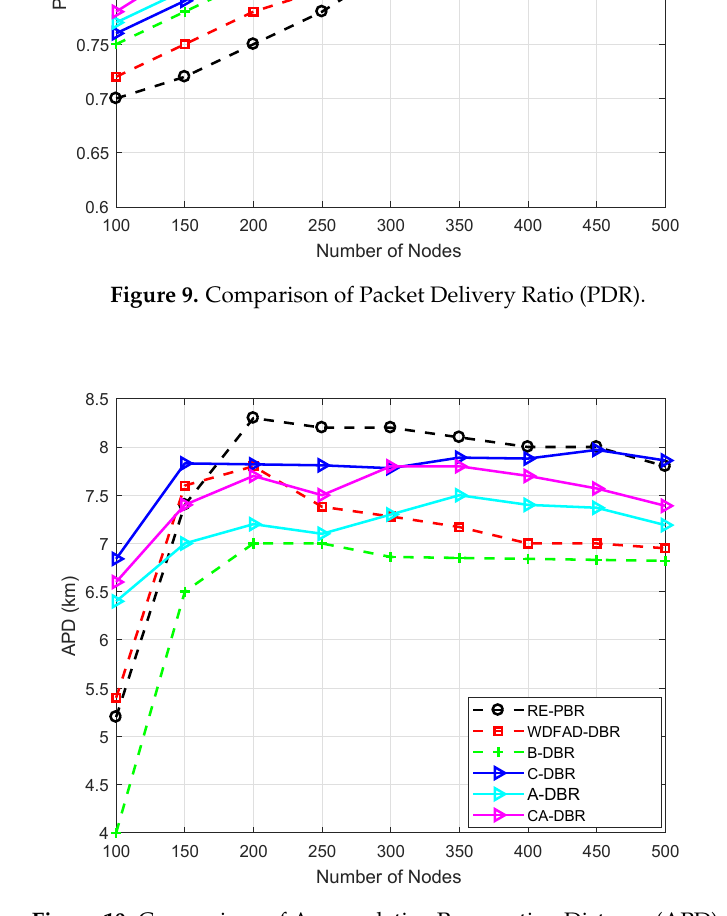
Figure 10. Comparison of Accumulative Propagation Distance